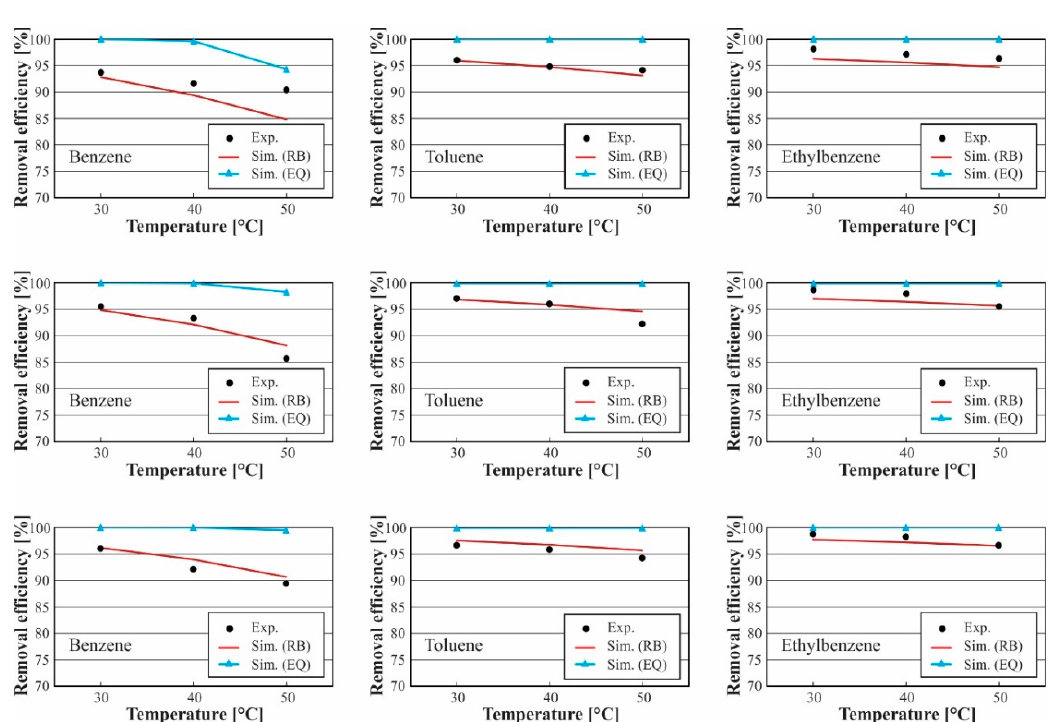
Figure 8. Effect of solvent temperature on the removal efficiency of tar components at a bed height of 0.8 m and different solvent volumetric flow rates 53 mL/min (above), 63 mL/min (middle), 73 mL/min (below).